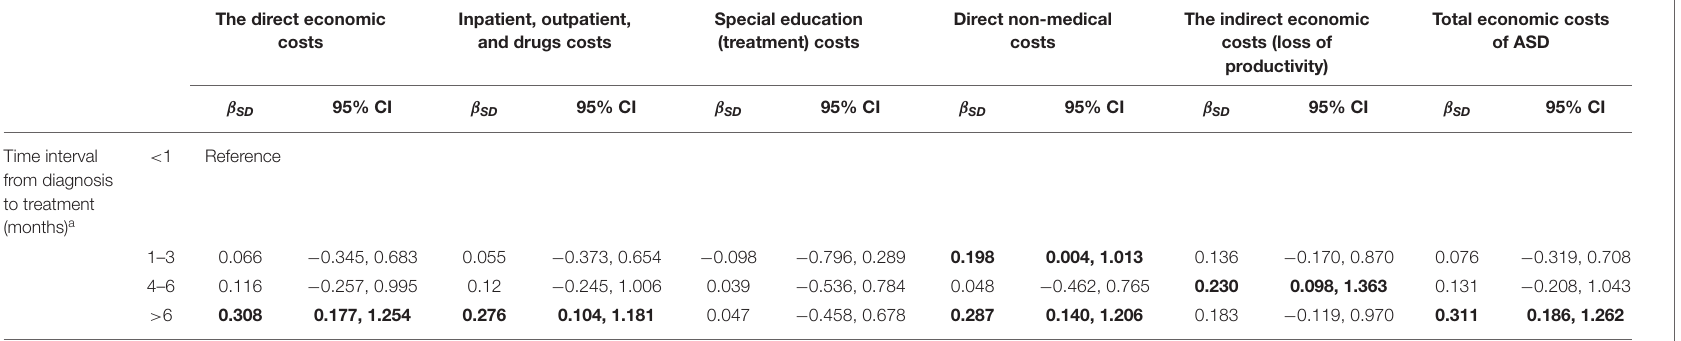
TABLE 4 | Multiple linear regression models for economic costs in the 12-month period after diagnosis and time interval from diagnosis to treatment (months).